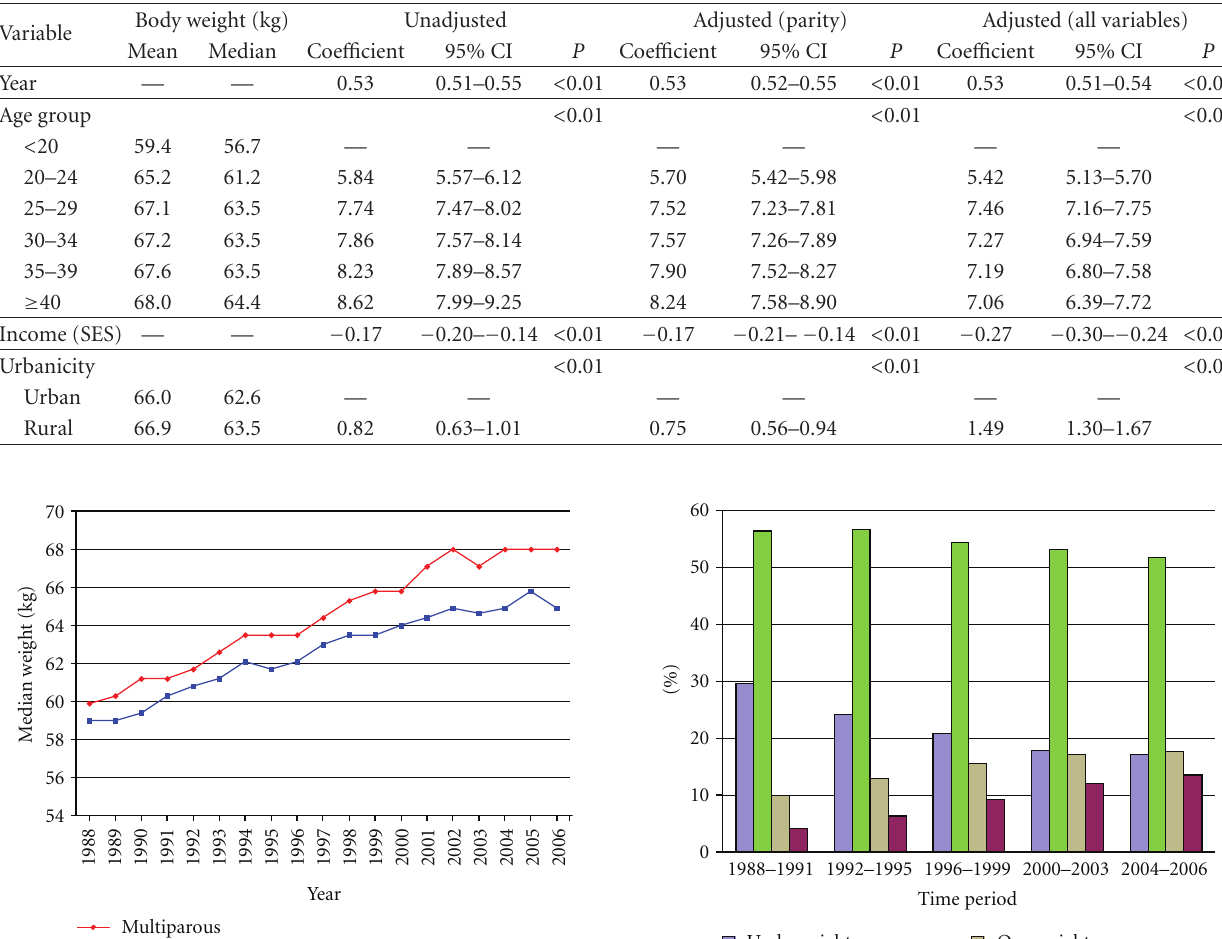
Table 1: Linear regression modelling of body weight in relation to demographic factors (i) unadjusted, (ii) adjusted for parity, and (iii) adjusted for parity and all other variables.